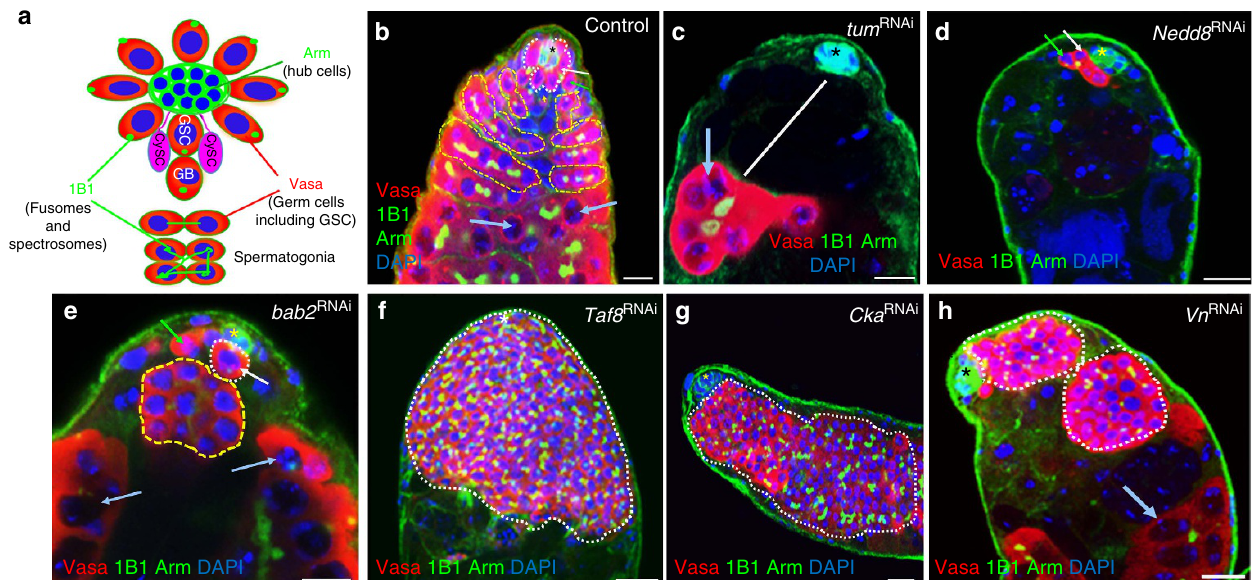
Figure 2 | Representative RNAi screen phenotypes using Act ts -Gal4 . ( a ) Diagram of GSC lineage and marker expression. GSCs and GBs have round spectrosomes (green dots) and spermatogonia contain branched fusomes (green branched lines). GSCs are enclosed by two CySCs (pink). ( b ) Wild-type (WT) control. ( c ) Knockdown of tum resulted in GSC loss and premature differentiation into spermatogonial cells (white arrow). ( d ) Knockdown of Nedd8 resulted in GSC loss and death of differentiated cells. ( e ) Knockdown of bab2 ( bric a brac 2 ) resulted in GSC loss and GSCs that directly differentiated into spermatogonial cells (yellow dotted line) and spermatocytes (light blue arrows). ( f ) Knockdown of Taf8 resulted in GSC differentiation defects. ( g ) Knockdown of Cka ( Connector of kinase to AP-1 ) resulted in GSC overproliferation at the expense of terminal differentiation. ( h ) Knockdown of Vein ( Vn) resulted in GSC differentiation defects. Testes of the indicated flies were dissected, stained with antibodies to Vasa (red, marks all germ cells including GSCs), Arm (green, hub cells at the apex), 1B1 (green, marks round spectrosomes and branched fusomes) and DAPI (blue, marks the nuclei), and analysed by confocal microscopy. Asterisks indicate hub cells. White arrows near hub cells indicate GSC and green arrows indicate GBs (in b , d , e ), and light blue arrows ( b , c , e , h ) indicate spermatocytes. White dotted lines indicate GSCs (near hub in a ) and GSC-like cells (in f – h ). Scale bars, 10 m